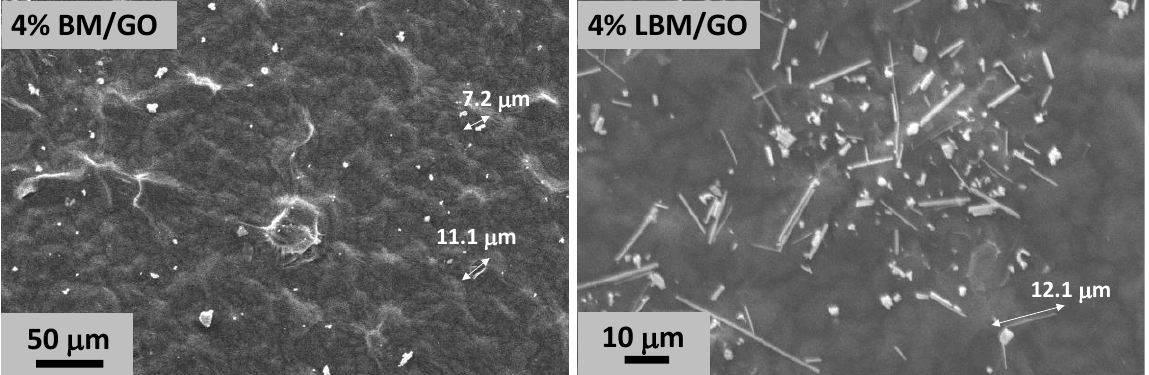
Figure 4. Pore distribution curves of 4% BM/GO and 4% LBM/GO composites.